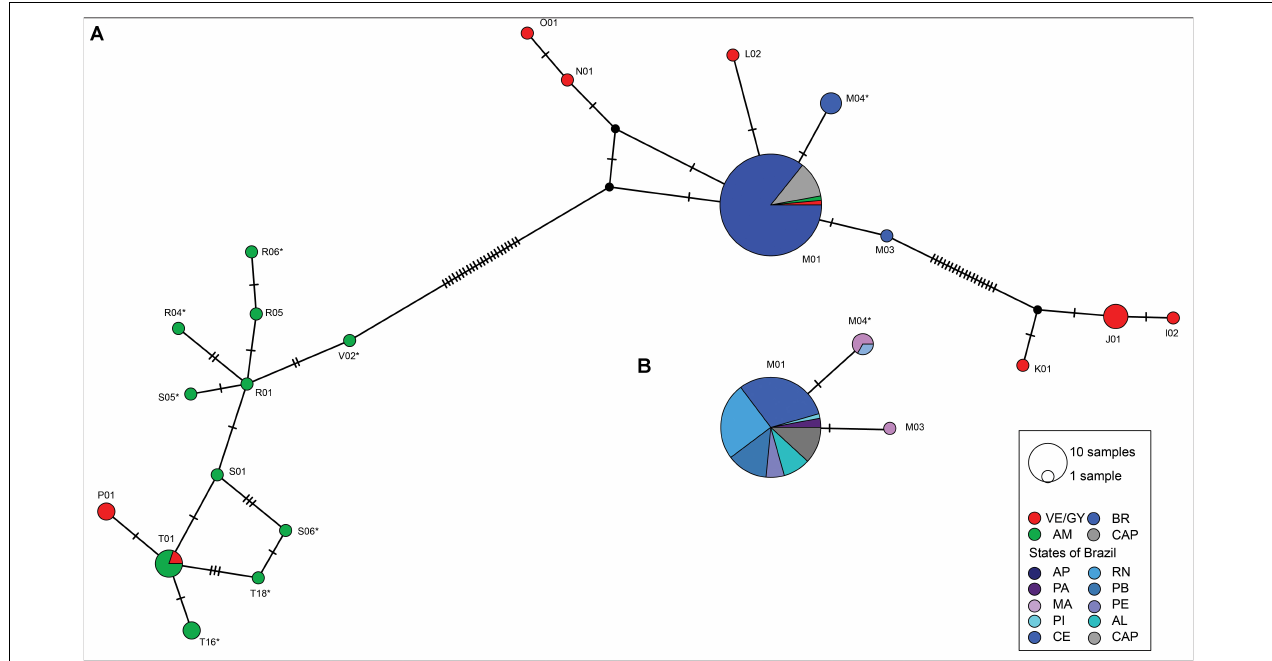
FIGURE 4 | Control Region mtDNA simplified haplotype networks (epsilon = 0) with colors marking genetic grouping. (A) All study samples with mitochondrial haplotypes from Brazil (BR), Venezuela (VE)/Guyana (GY), and Amazonian (AM), and manatees from captivity. (B) Brazilian samples from states in the northeast coast of Brazil (see main text for abbreviations). Size of the circles represent sample size with sectors of circles indicating samples from different locations with shared haplotypes. Black tick marks indicate the number of mutations separating the various haplotypes. Haplotypes are labeled according to Vianna J. A. et al. (2006). New haplotypes found in this study are indicated with an asterisk (*). Manatees from captivity were included in the haplotype network. The identified hybrid, “Poque” (T01), was assigned to the Venezuela/Guyana group through the Bayesian analyses.